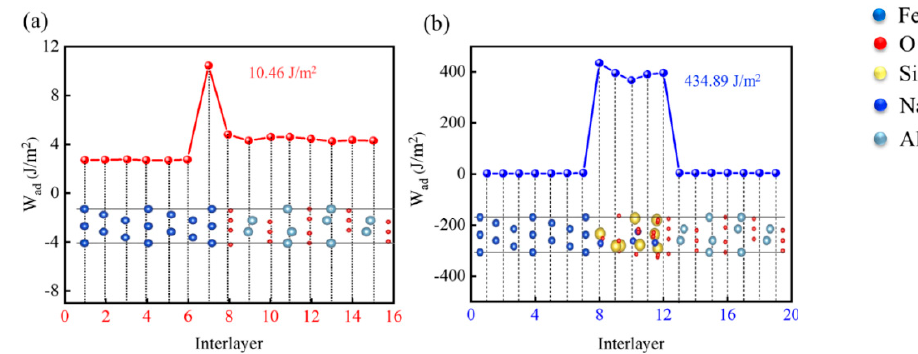
Figure 5. The adhesion work for the ( a ) Fe − Al 2 O 3 and ( b ) Fe − amorphous Na 2 SiO 3 − Al 2 O 3 interfaces as a function of the number of atomic layers.